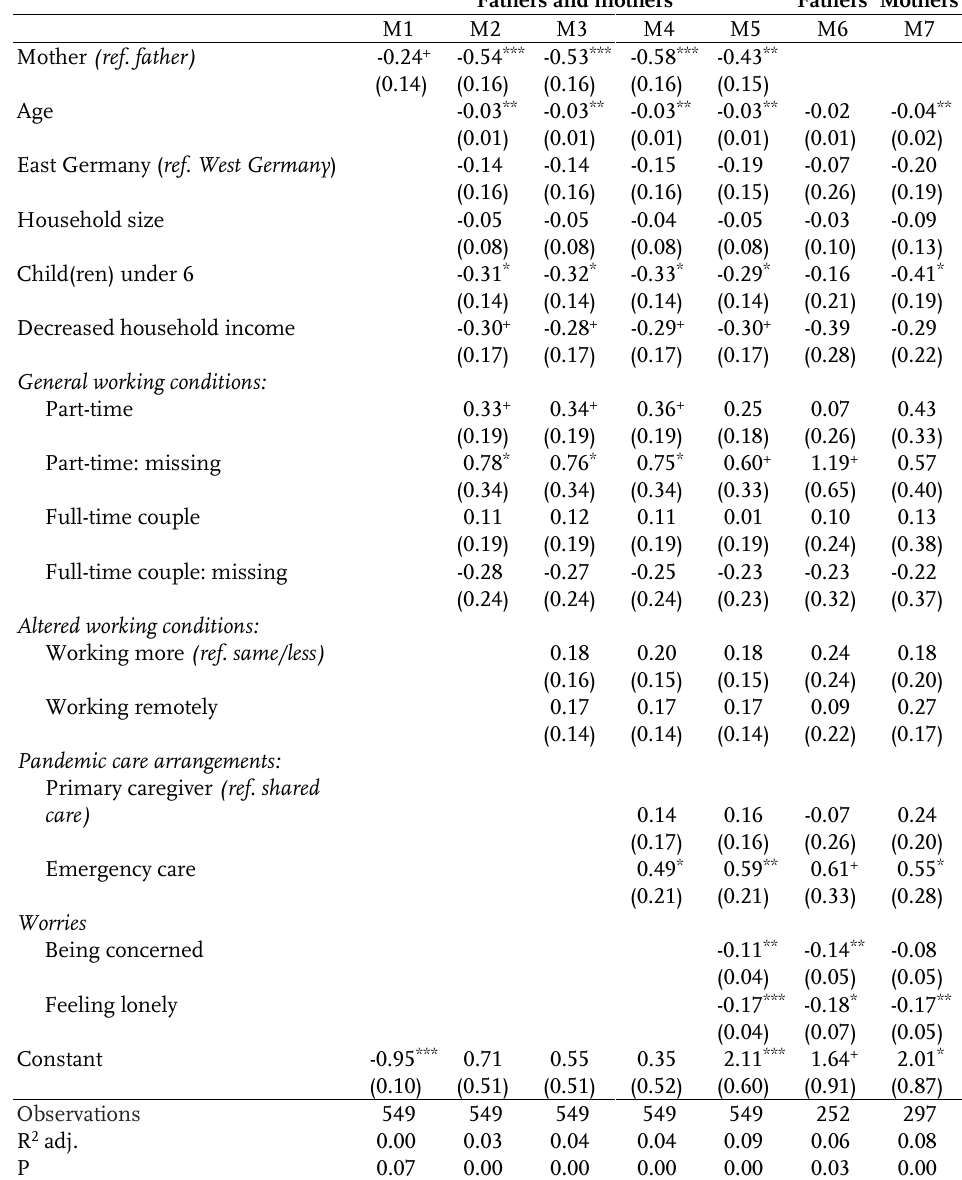
Table 2: Change score stepwise linear regressions models for life satisfaction (OLS)